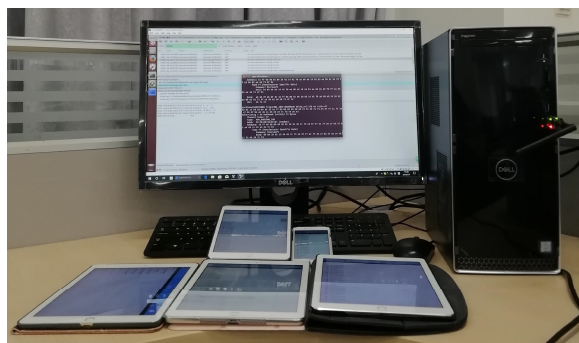
Figure 6. Privacy experiment platform for LE Bluetooth devices.